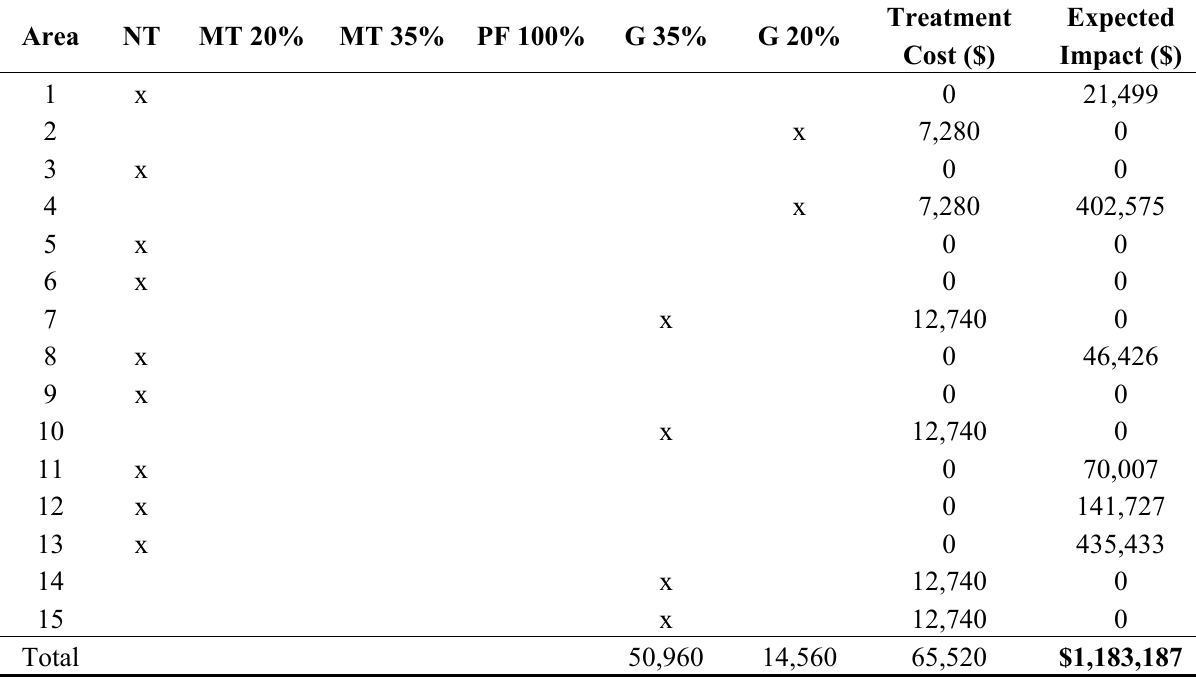
Table 6. Optimal fuel treatment plan based on an ecosystem services factor of 50 and fireline intensity threshold of 1000 kW/m.